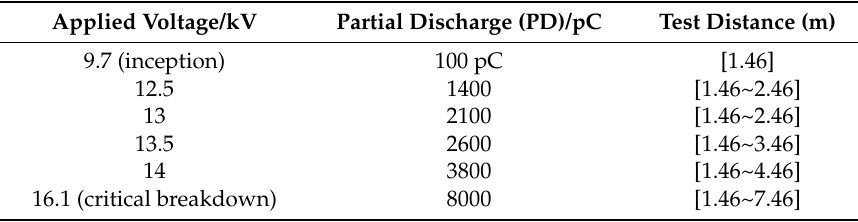
Figure 8. Experimental setup in the laboratory. Table 2. Data of the test conditions.